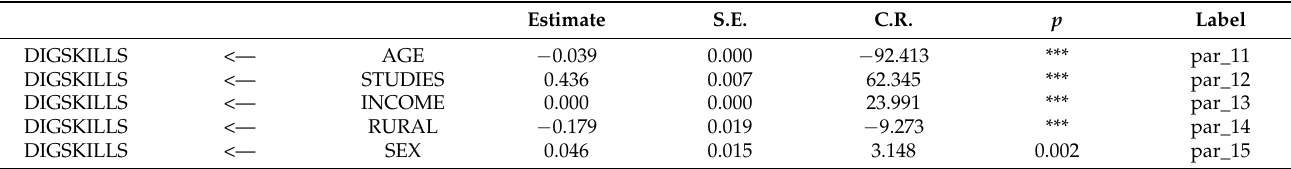
Table A7. Regression Weights: (Group number 1-Default model).